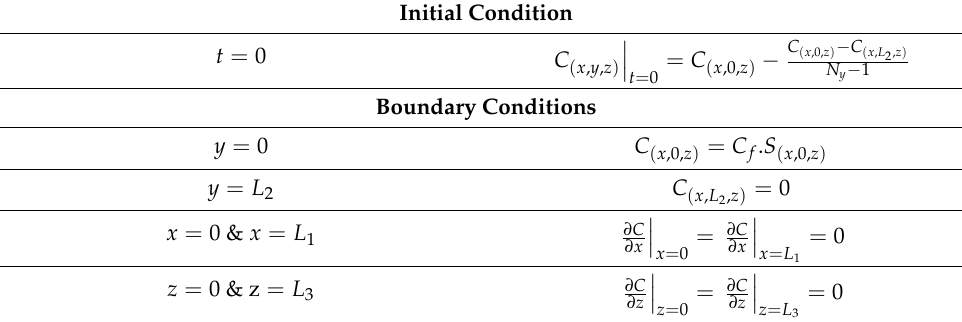
Table 1. Initial and boundary conditions used in all